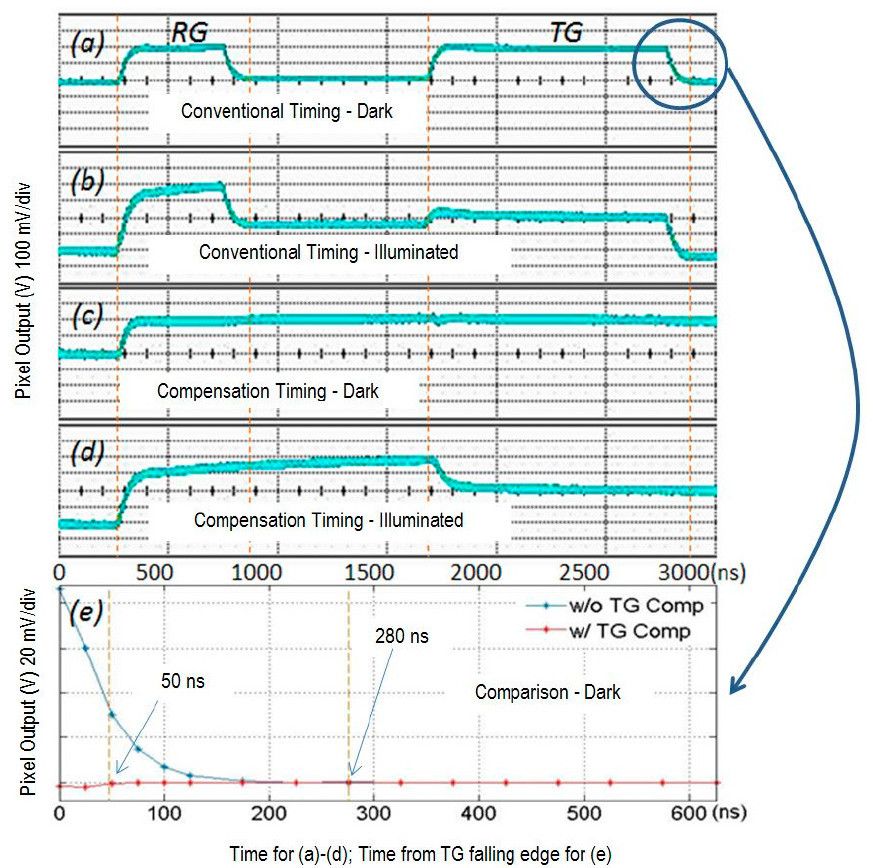
Figure 8. Analog output waveforms vs. time from TG falling edge.